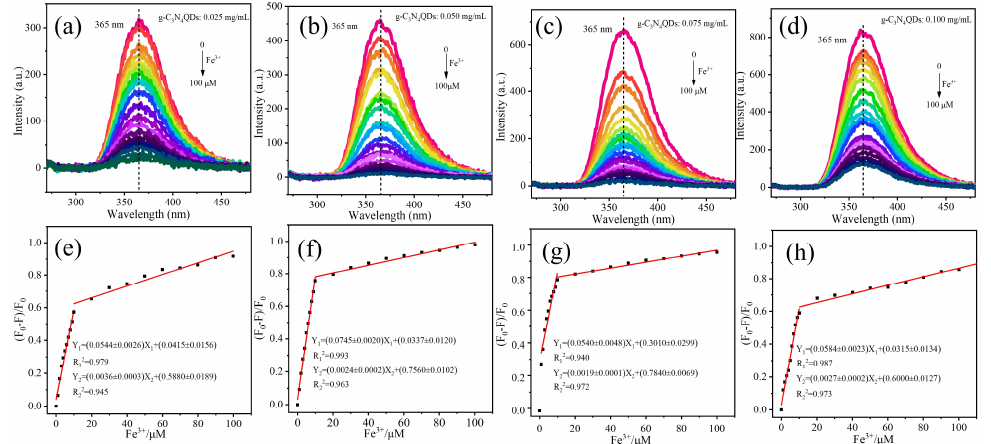
Figure 5. ( a – d ) Fluorescence responses of different concentrations of g-C 3 N 4 QDs in the presence of different concentrations of Fe 3+ (excitation wavelength, 247 nm). ( e – h ) The relationship between the fluorescence quenched ratio and the concentration of Fe 3+ from 0 to 100 μM.